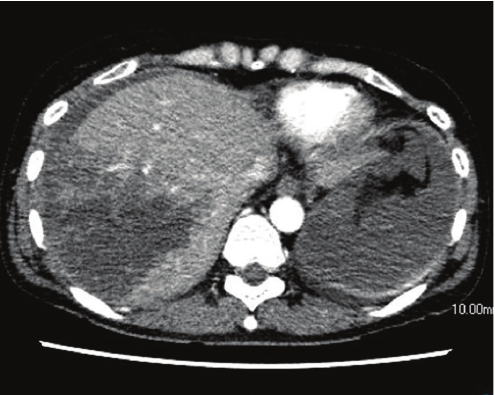
Figure 1: Enhanced CT on admission. Enhanced CT shows a deep liver laceration (Grade IV on the Organ Injury Scale of the American Association for Surgery of Trauma) without extravasation or pseudoaneurysm or arterioportal fistula formation.